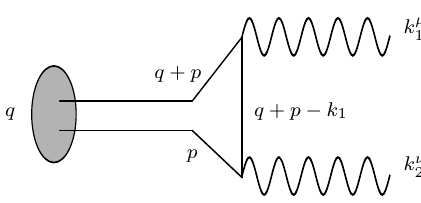
Figure 4 . We show the triangle diagram (a quark loop of solid line) of a composite boson (two parallel solid lines associating to a pseudo-scalar vertex γ 5 ) decaying into the two SM gauge bosons (two wave lines associating to two vector-like vertexes γ µ and γ ν